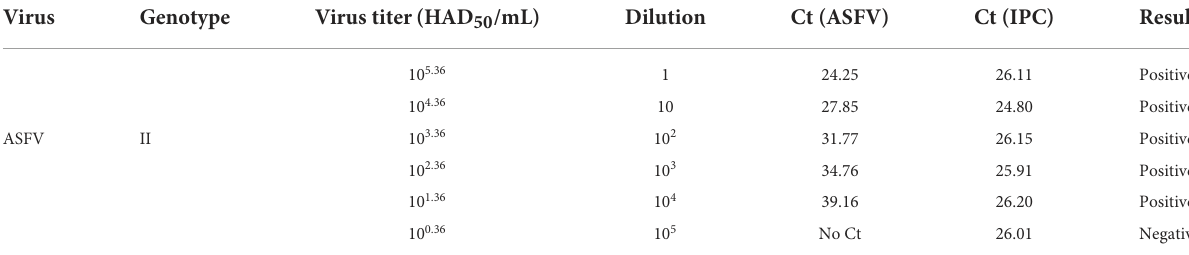
TABLE 5 Analytical sensitivity measured with a known viral titer. Virus